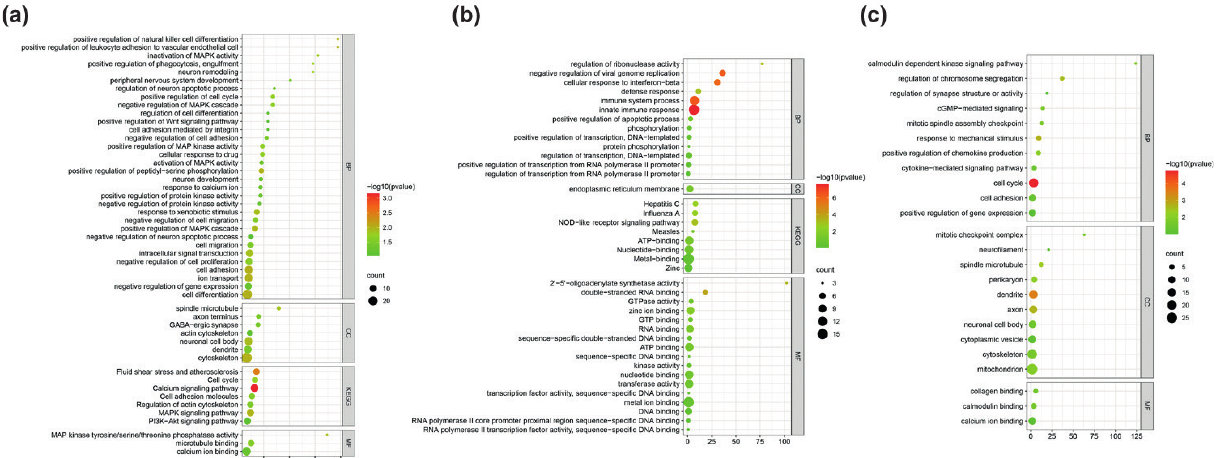
Fig. 3. GO and KEGG analyses of differentially expressed genes in different treatment groups compared with the control group. (a) Analysis of differentially expressed genes GO and KEGG enrichment in the SPIOs group compared with the control group. (b) Analysis of differentially expressed genes GO and KEGG enrichment in the SMF group compared with the control group. (c) Analysis of differentially expressed genes GO enrichment in the SMF + SPIOs group compared with the control group. The size of the dots represents the number of differentially expressed genes enriched, and the larger dots represent more genes enriched; the color of the dots represents the P value of the significance level of differentially expressed genes, and the redder the color represents the larger the P value and greener colors represent smaller P